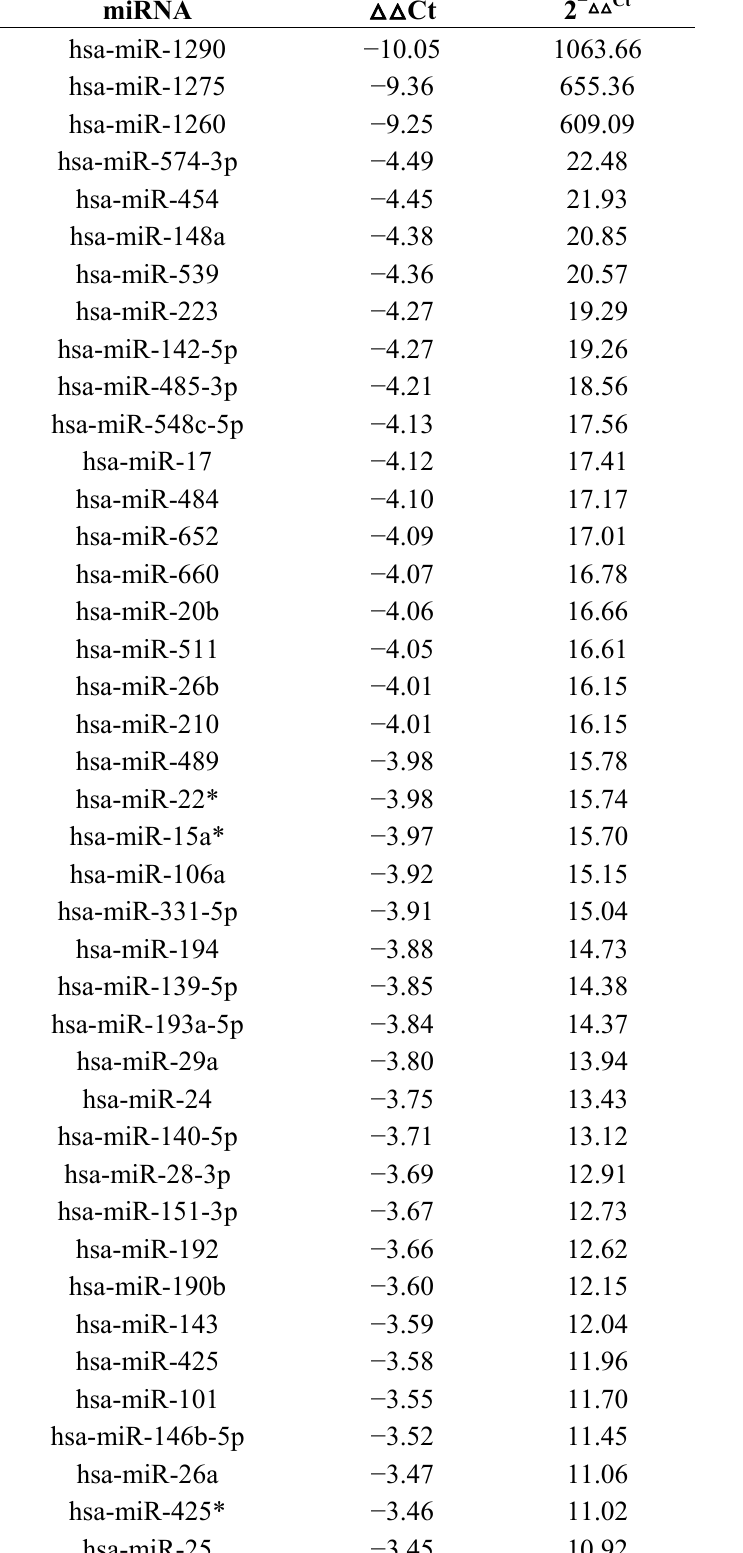
Table A1. Differential expressed miRNAs in H7N9 virus-infected patients compared with healthy